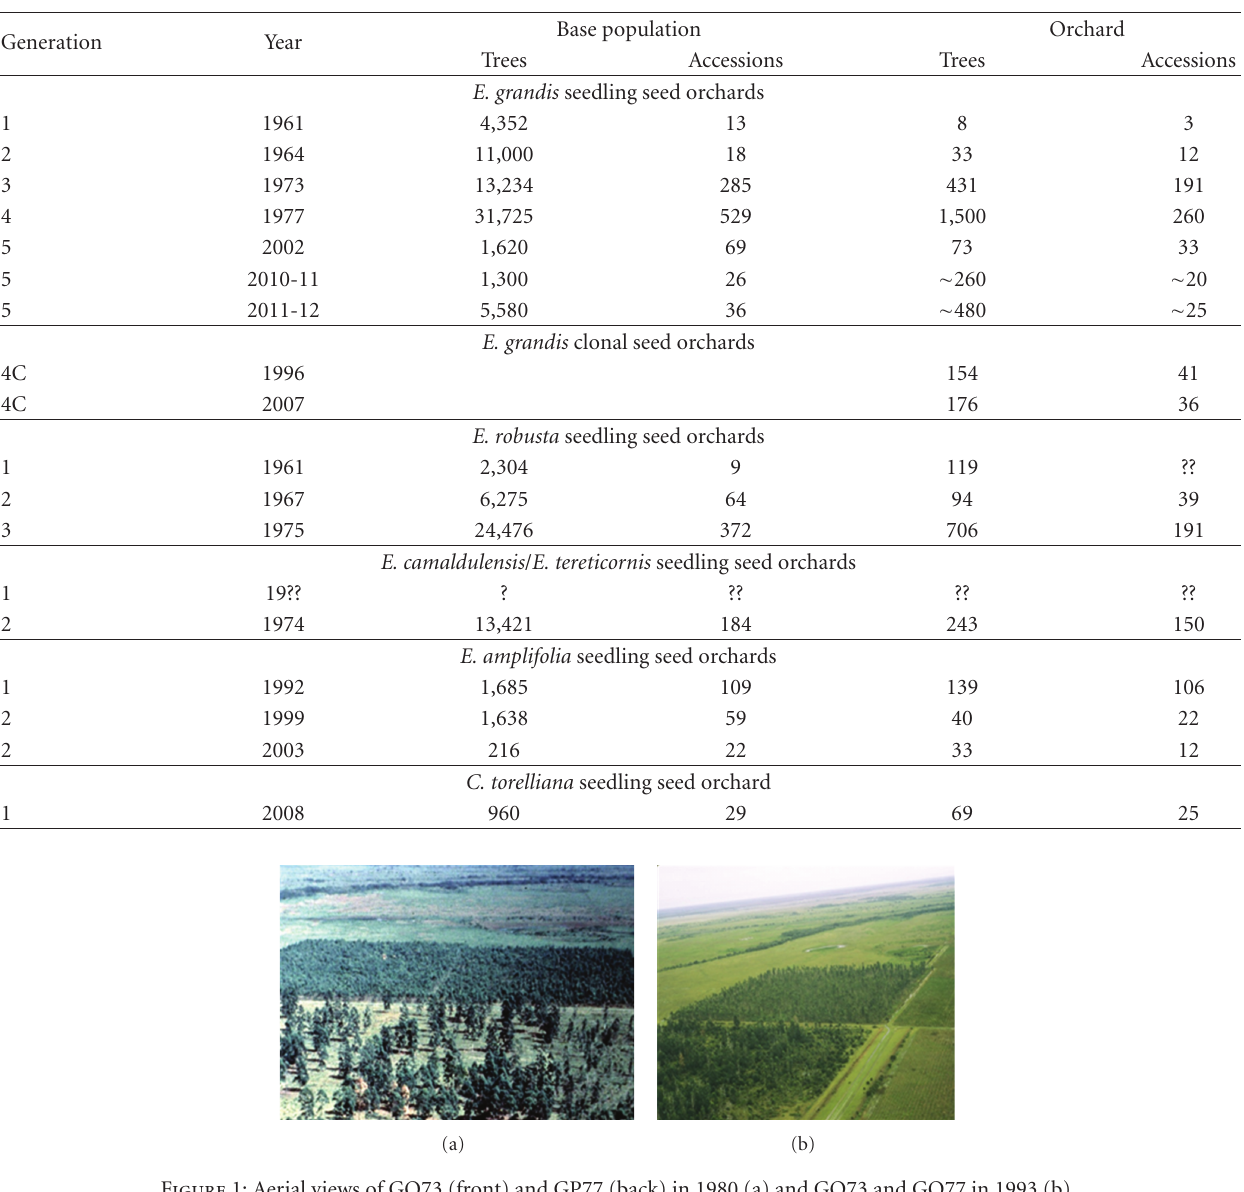
Figure 1: Aerial views of GO73 (front) and GP77 (back) in 1980 (a) and GO73 and GO77 in 1993